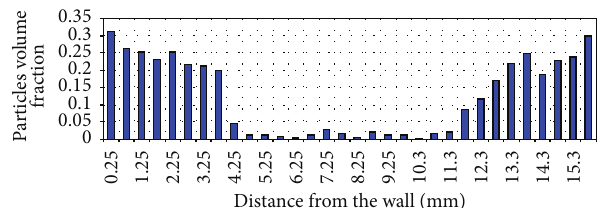
Figure 10: Distribution of the volume fraction of reinforcement of the one-side reinforced disc.